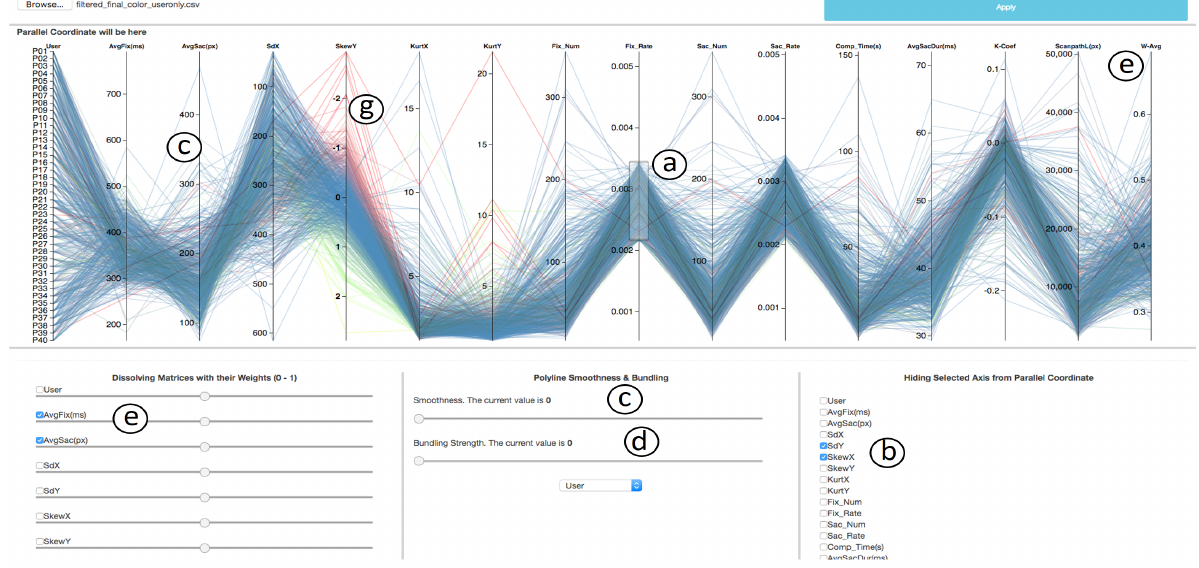
Figure 4. Overview of the parallel coordinates tool. Axis-aligned brushing is shown in (a). Axes can be deleted by (b), polylines that pass through an axis can be smoothed if needed (c), curves can be bundled around a centroid using this option (d), two or more metrics can be added with weights (e), color coding to distinguish the cluster based on data value in a specific metric can be applied as shown in (f).